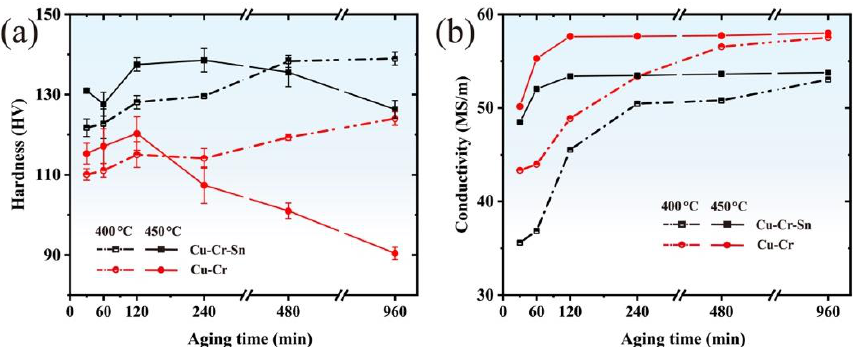
Figure 1. ( a ) Hardness and ( b ) electrical conductivity of Cu-Cr and Cu-Cr-Sn alloys aged at different temperatures.